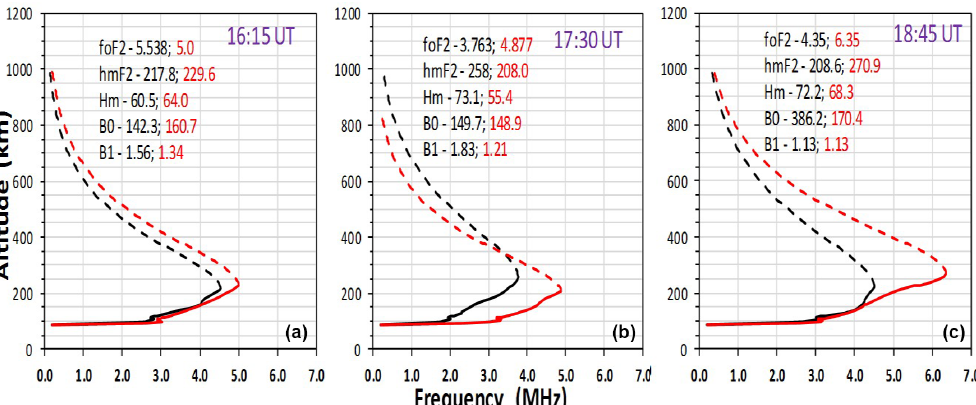
Figure 6. Example of the ionospheric profile at the eclipse window of Idaho National Lab showing the bottomside profile (continuous line) and the modelled topside profile shown as a dashed line. The maximum point of the continuous line is the point in which the peak value of the measured foF2 and hmF2 are obtained. The respective measured values foF2 and hmF2 and the corresponding B1 , B0 , and H m parameters values are provided in the plot. The black curve represents the profile for the eclipse day (21 August) and the red curve is for the selected reference day, 27 August. Panel (a) shows the profile during the first contact of the eclipse, and (b) and (c) show profiles for the maximum contact and the last contact of the eclipse